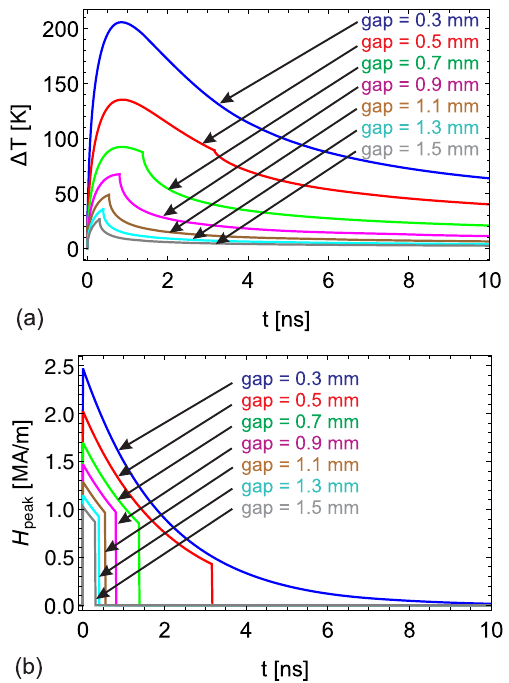
FIG. 6. Temperature variation in a cell, generated by a 3.2 nC bunch of 50 μ m, without taking into account the coupler reflections (a) and surface peak magnetic field as a function of the time (b).